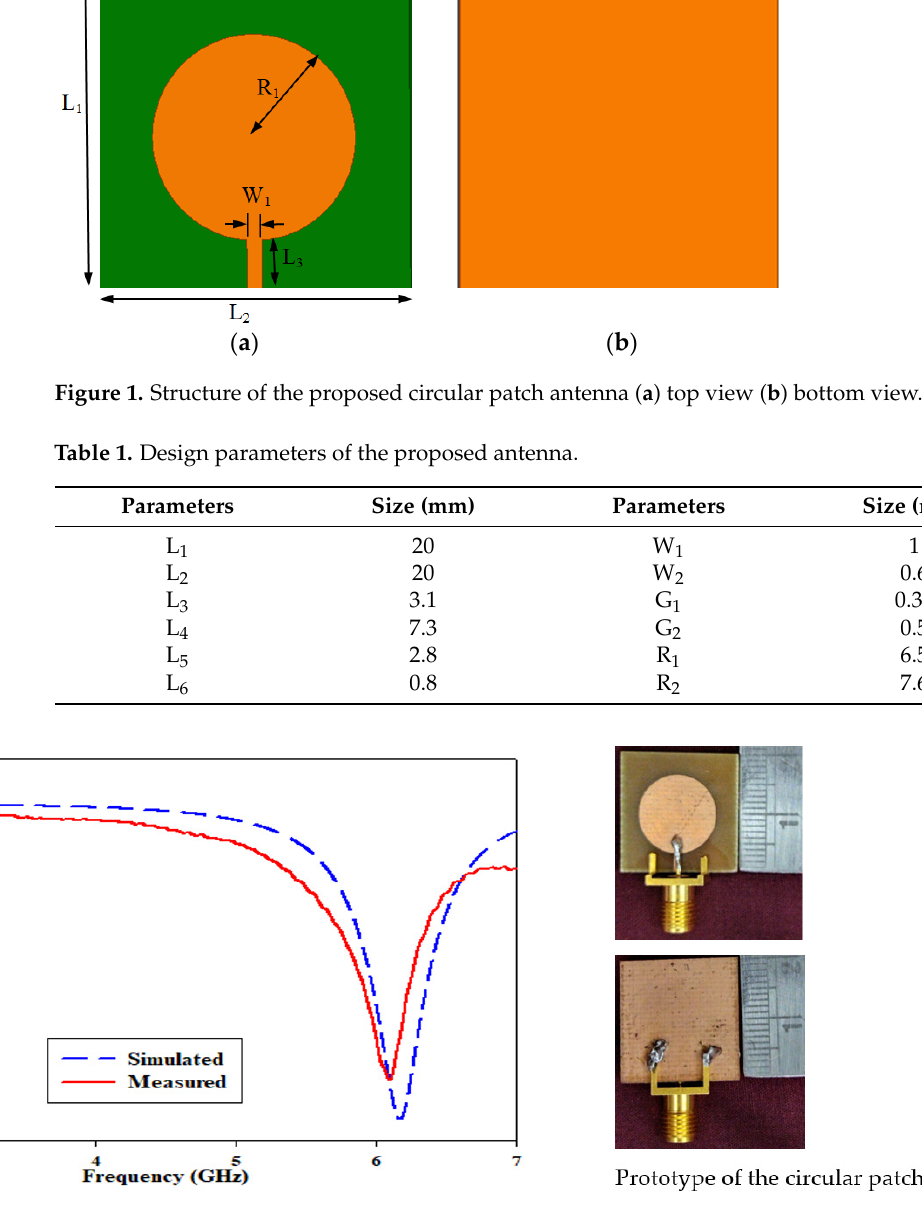
Figure 2. Simulated and measured return loss characteristics of the circular patch antenna.